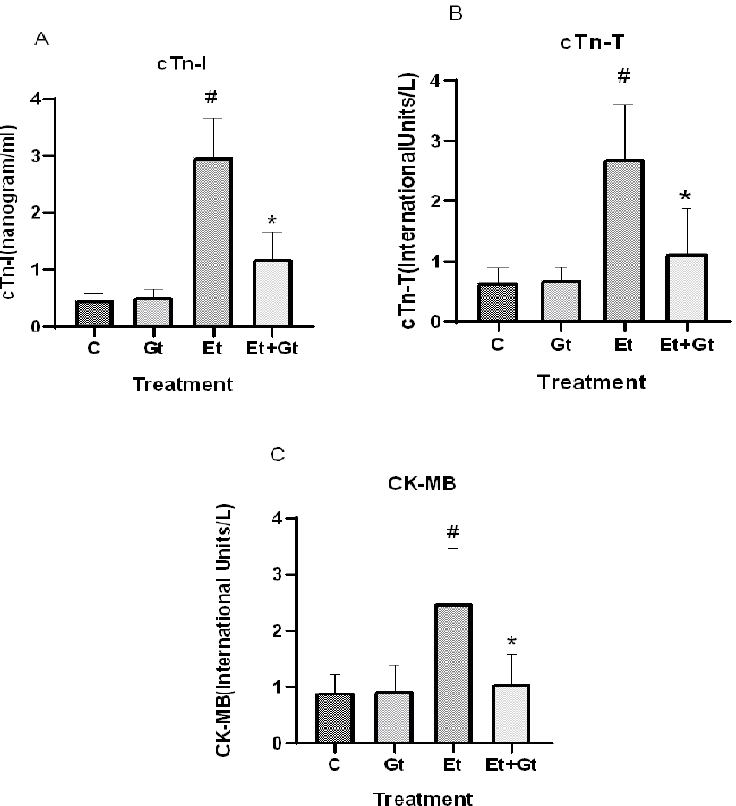
Figure 4. Changes in cTn-I ( A ), cTn-T ( B ) and CK-MB ( C ) levels in plasma of control (C), 6-gingerol (Gt)-, ethanol (Et)- and ethanol plus 6-gingerol (Et + Gt)-treated groups. The data are expressed as mean ± SD. # p < 0.05 compared with control and * p < 0.05 compared with ethanol-treated groups.